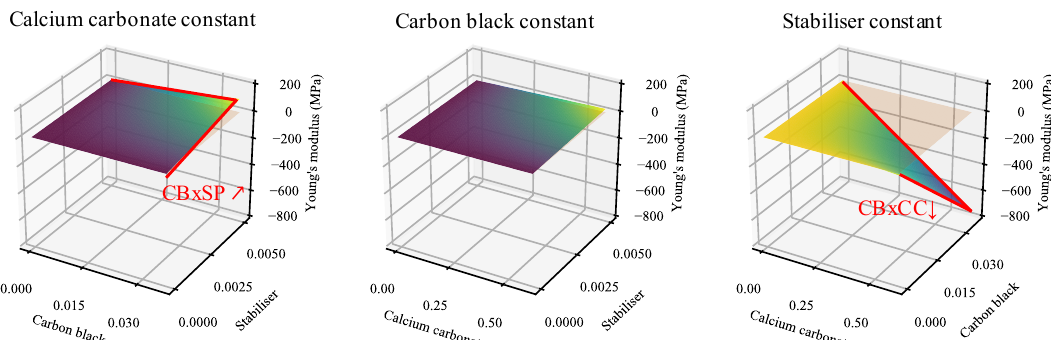
Figure 4. Weld-line Young’s modulus model predictions for interactive effects. Note the very strong antagonistic interaction between CB and CC, as well as the slightly positive interaction between CB and